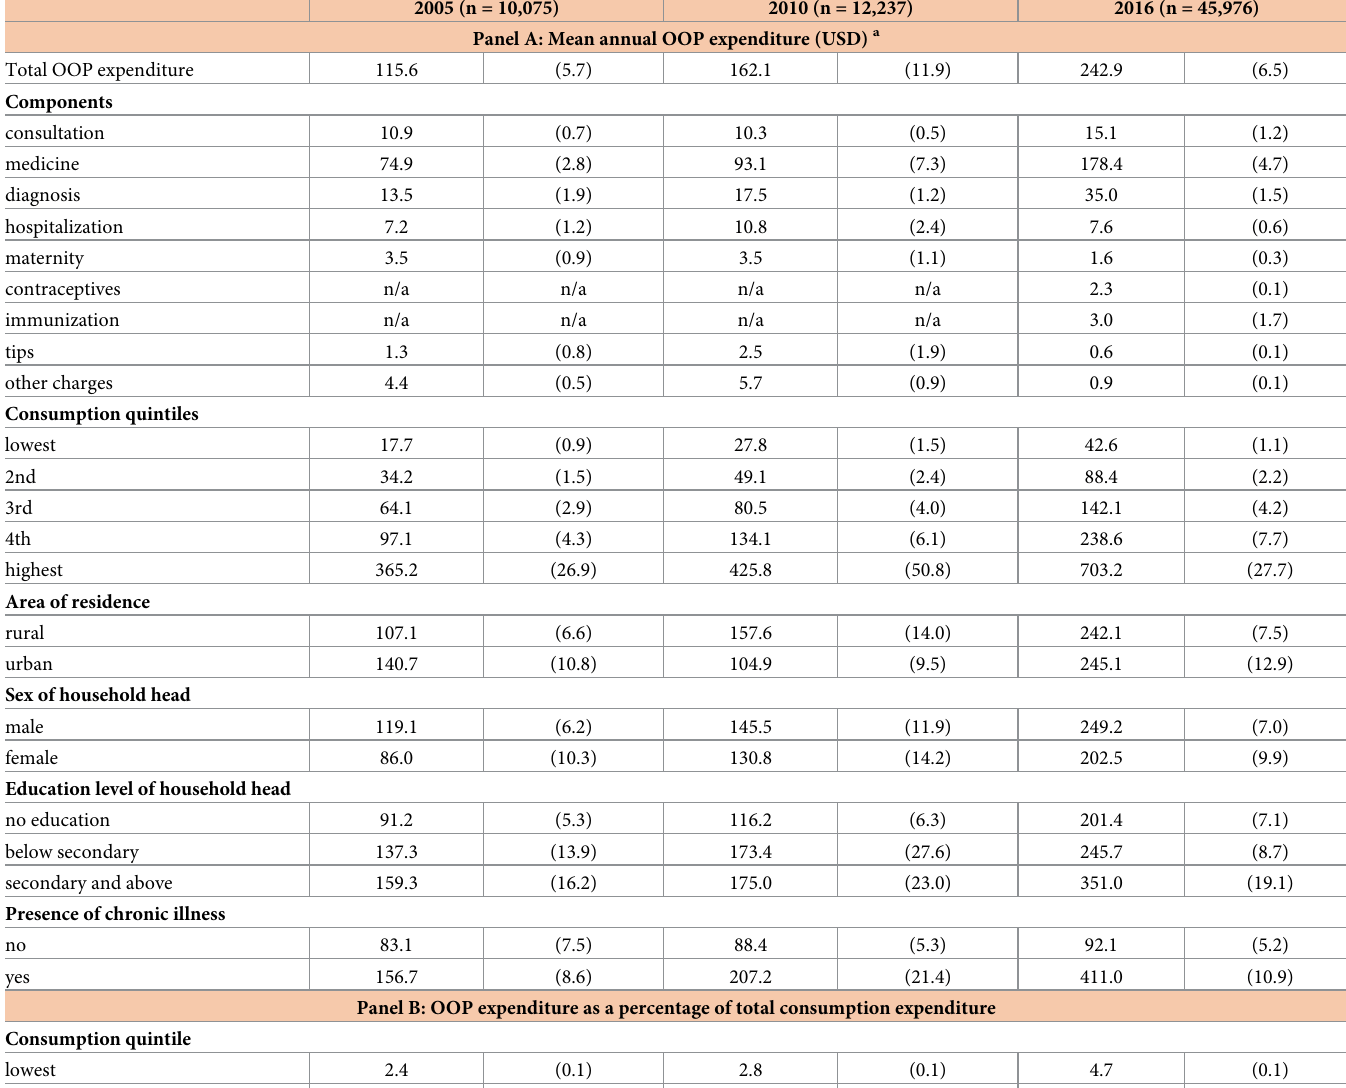
Table 1. The levels and distributions of out-of-pocket (OOP) expenditure (in absolute and relative